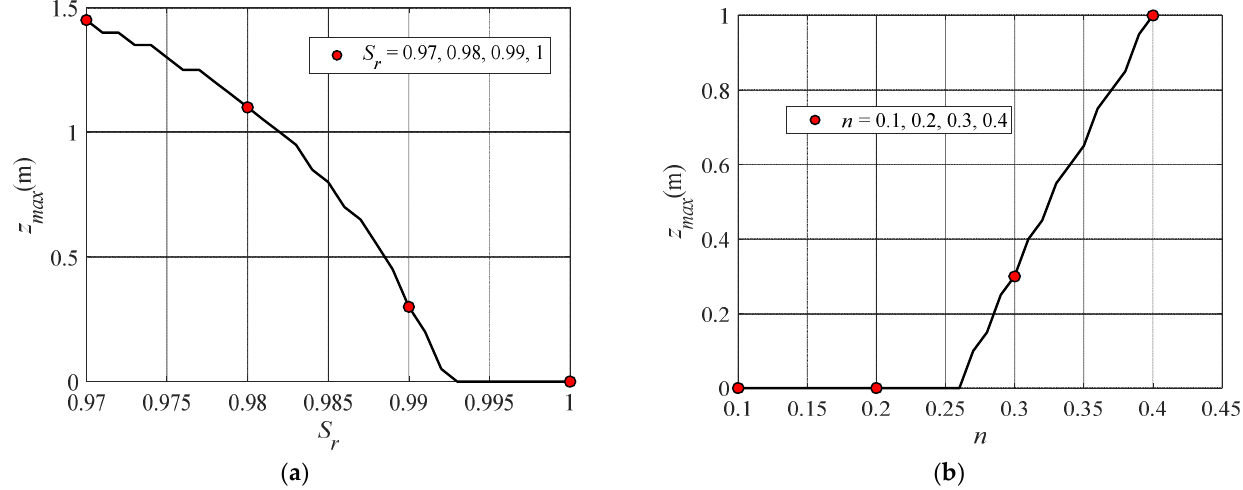
Figure 26. Maximum liquefaction depth with varying ( a ) degrees of saturation and ( b ) porosities .